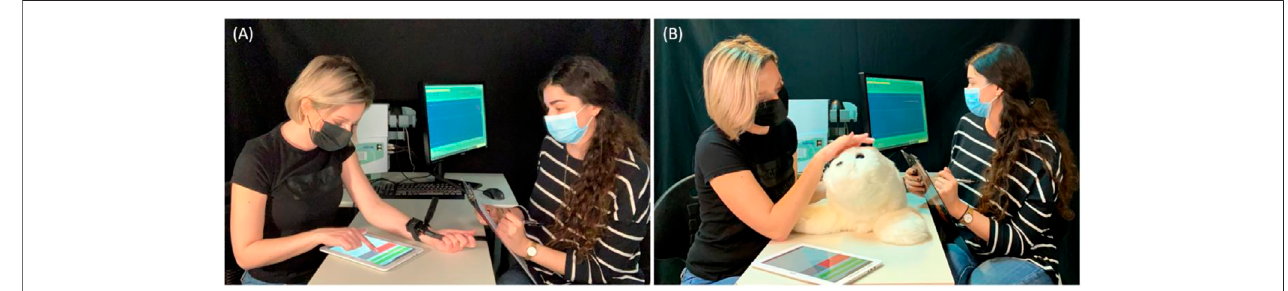
FIGURE1| Anillustrationoftheexperimentalsetup.Theparticipant(ontheleft)hasthethermalstimulatorplacedonhernon-dominantarm,whichisplacedonthe table. The experimenter (on the right) administers the accurate heat stimuli, and tracks them on the screen. (A) Baseline condition; PARO is not present. The participant uses the custom-made VAS application to rate pain levels. In order to rate the intensity of pain, the participants were asked to slide their fi nger from left to right on the screen of the tablet. Sliding the fi nger revealed a red area that expanded as the participant slid her fi nger further to the right. The leftmost edge of the screen was de fi ned to have a value of zero (no pain), and the rightmost edge was de fi ned to have a value of 10 (the most intense pain). (B) Touch condition; PARO is placed on the table next to the participant, who touches it during the administration of the heat stimuli.